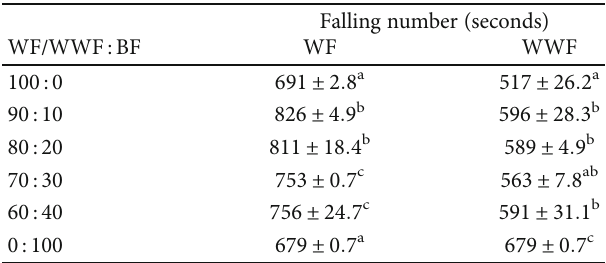
Figure 2: Scanning electron microscope (SEM) images of white wheat, whole wheat, and chickpea fl ours, doughs, and their blends. (a) SEM of fl ours: top, white fl our; middle, whole wheat fl our; bottom, chickpea fl our. (b) SEM of doughs: top, white fl our dough; middle, whole wheat fl our dough; bottom, chickpea fl our dough. (c) SEM of doughs made with wheat fl our and chickpea fl our blends: top, WF :BF with 60 :40 blends; bottom, WWF: BF with 60 :40 blends. Table 2: Falling number values of the white fl our, whole wheat fl our, chickpea fl our, and their